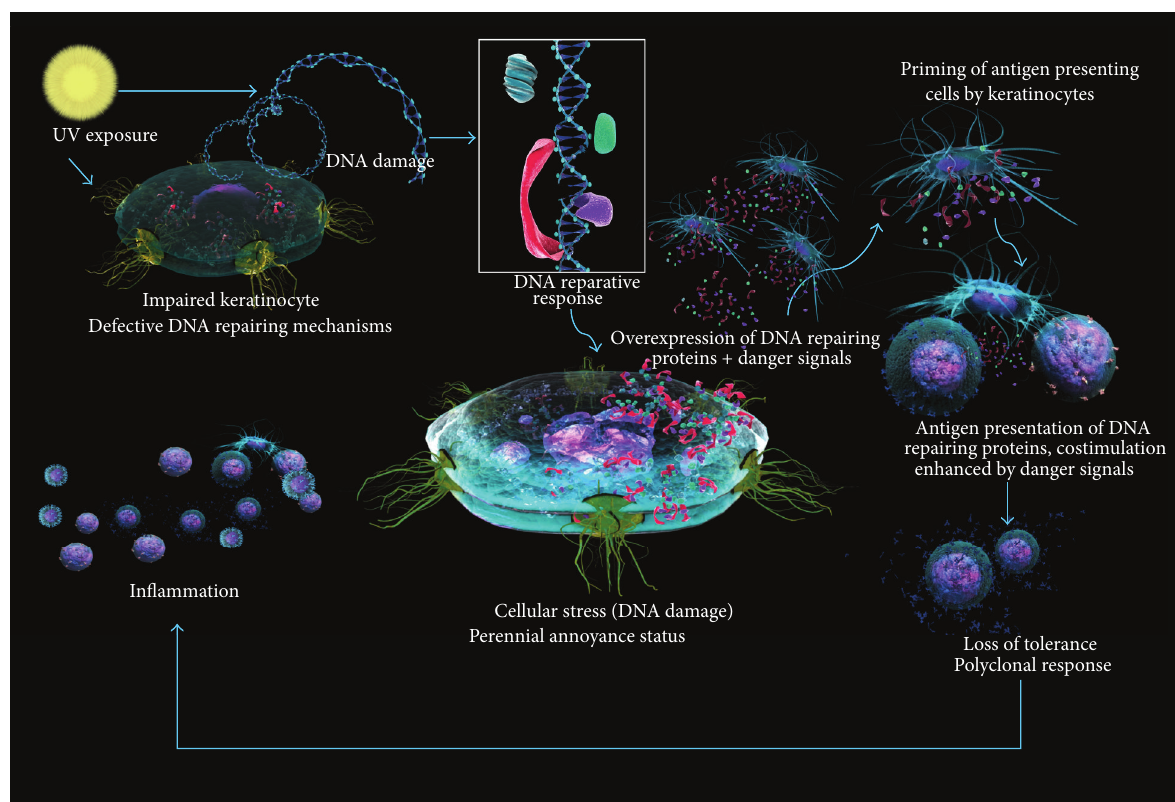
Figure 2: The sun-burned defective DNA repairer keratinocyte in SLE. The exposure of the keratinocyte DNA to UV radiation infringes DNA damage, which cannot be normally repaired because of faulty enzymes. DNA repairing proteins are upregulated and therefore presented as antigens; in the stressed context costimulatory molecules are upregulated and an autoimmune response toward nucleoproteins is settled. Repetitive cycles of UV radiation perpetuate the immune process because the tissue is harmed again and releases danger